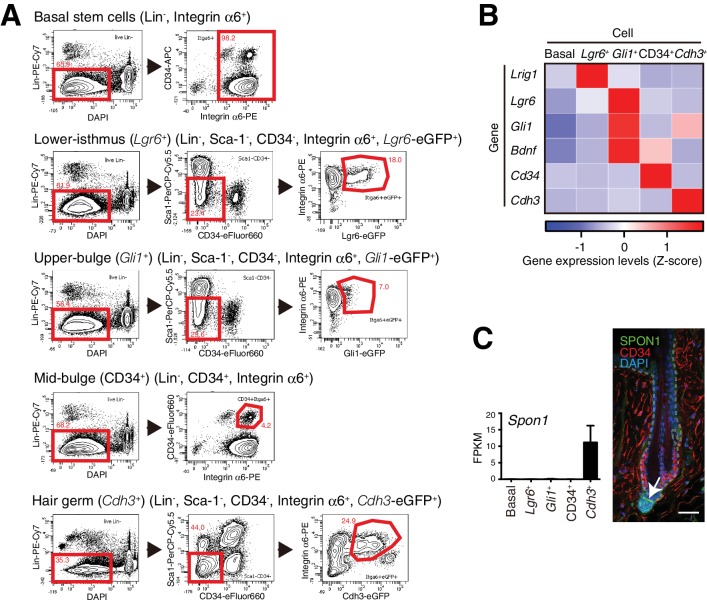
FACS-based cell isolation procedures for distinct epidermal stem cell populations.(A) FACS sorting procedures of all basal epidermal cell populations using wild-type C57BL/6N mice, Lgr6+ lower-isthmus epidermal stem cells using Lgr6-GFP-ires-CreERT2 mice, Gli1+ upper-bulge epidermal stem cells using Gli1-eGFP mice, CD34+ mid-bulge epidermal stem cells using wild-type C57BL/6N mice, Cdh3+ hair germ epidermal cells using Cdh3-eGFP mice. Gates are indicated by red-line boxes and cells in the gates were further analysed in the next plots or sorted. The numbers in the plots represent the percentage of cells in the gates. Lin- indicates lineage-negative cells, which are negative for the markers of haematopoietic and endothelial cells (lineage-positive cells). (B) Z-score heat map representing qRT-PCR analysis of sorted cells with compartment-specific gene primers. See Methods for more detail. Data are mean of 3–4 independently isolated biological replicates. (C) Expression levels of Spon1 gene in different stem cell pools. Immunostaining pattern of SPON1 protein in 8-week-old telogen dorsal hair follicle was shown. White arrow indicates the restricted localization of SPON1 in dermal papilla and the basement membrane between dermal papilla and hair germ. This restricted expression and deposition of SPON1 corroborates little contamination of hair germ cells into the Gli1 + upper bulge population. FPKM, fragments per kilobase of transcript per million mapped reads. Basal, basal epidermal stem cell pool. Data are mean ± SD, n = 3–4. Scale bar, 10 μm.